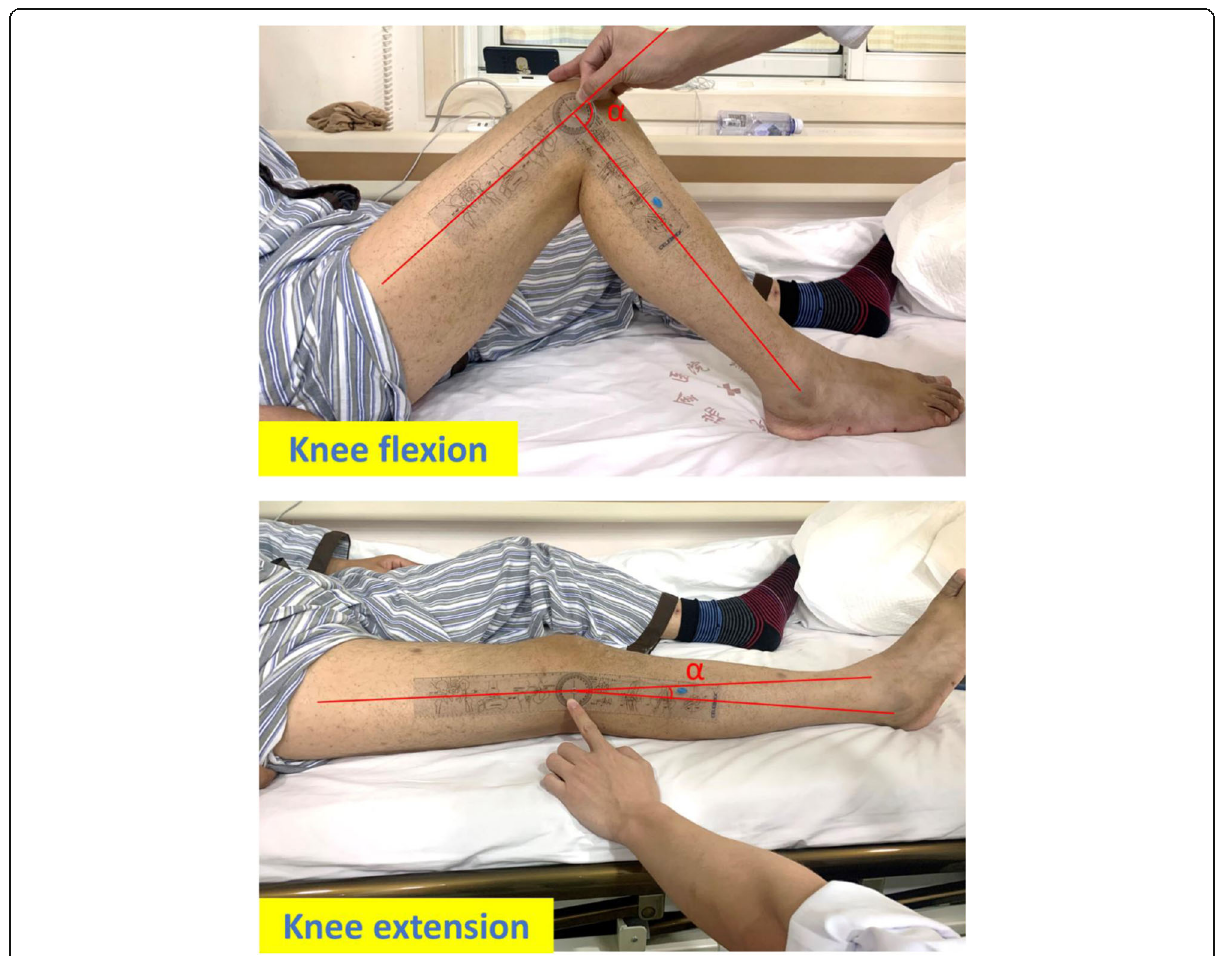
Fig. 1 The measurement method of extension angle/flexion angle defined by α